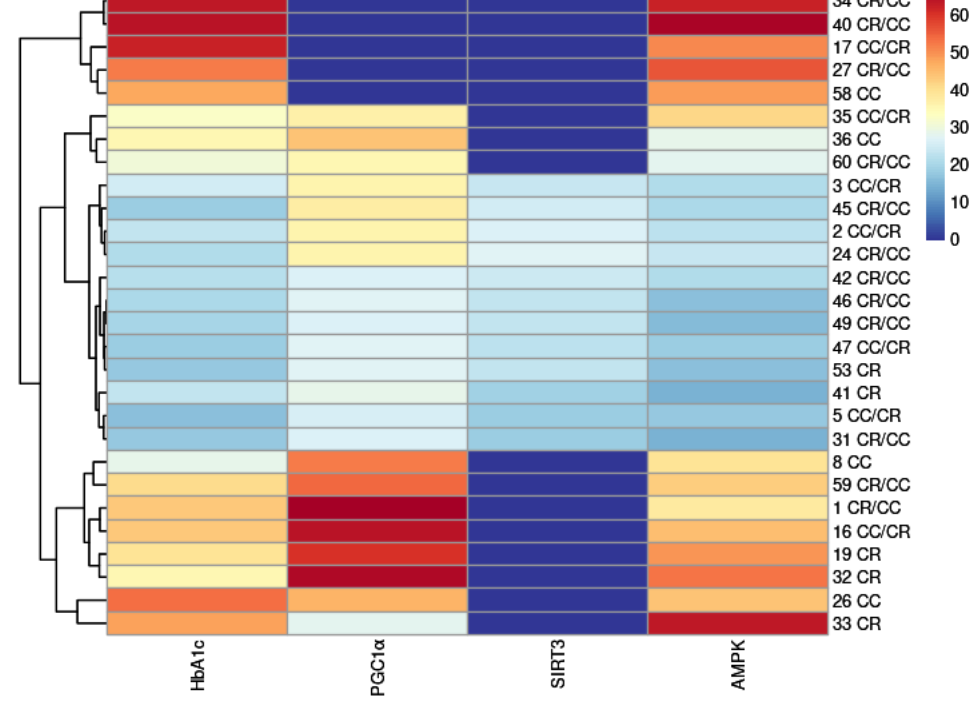
Figure 7. Heatmap of molecular docking.